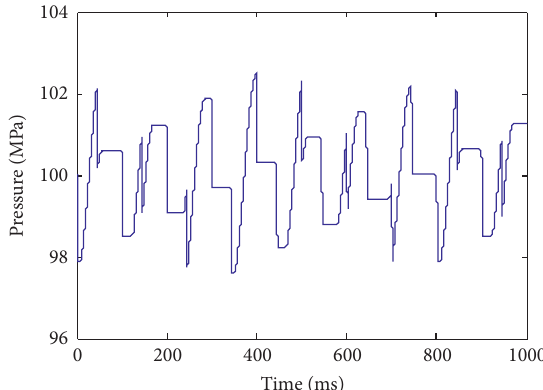
Figure 9: Changes in fuel pressure in high-pressure fuel line with two fuel